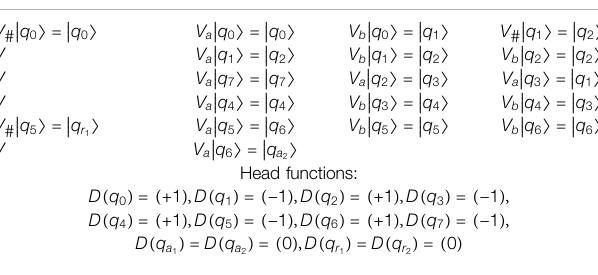
TABLE 1 | Details of the transition functions and head function for L 1